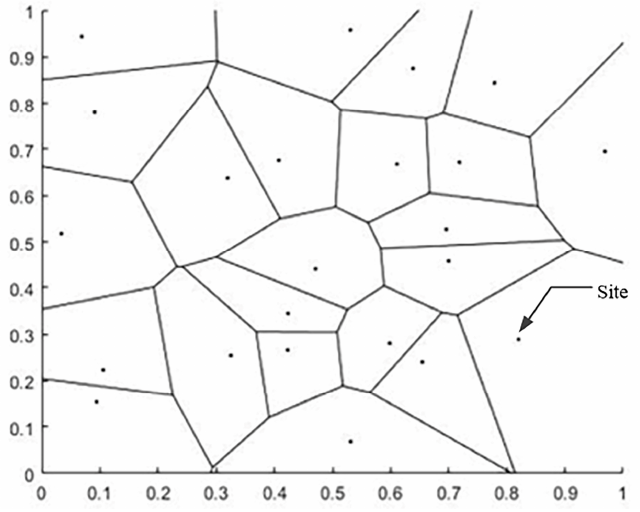
Figure 6. Voronoi diagram of 23 sites and regions.